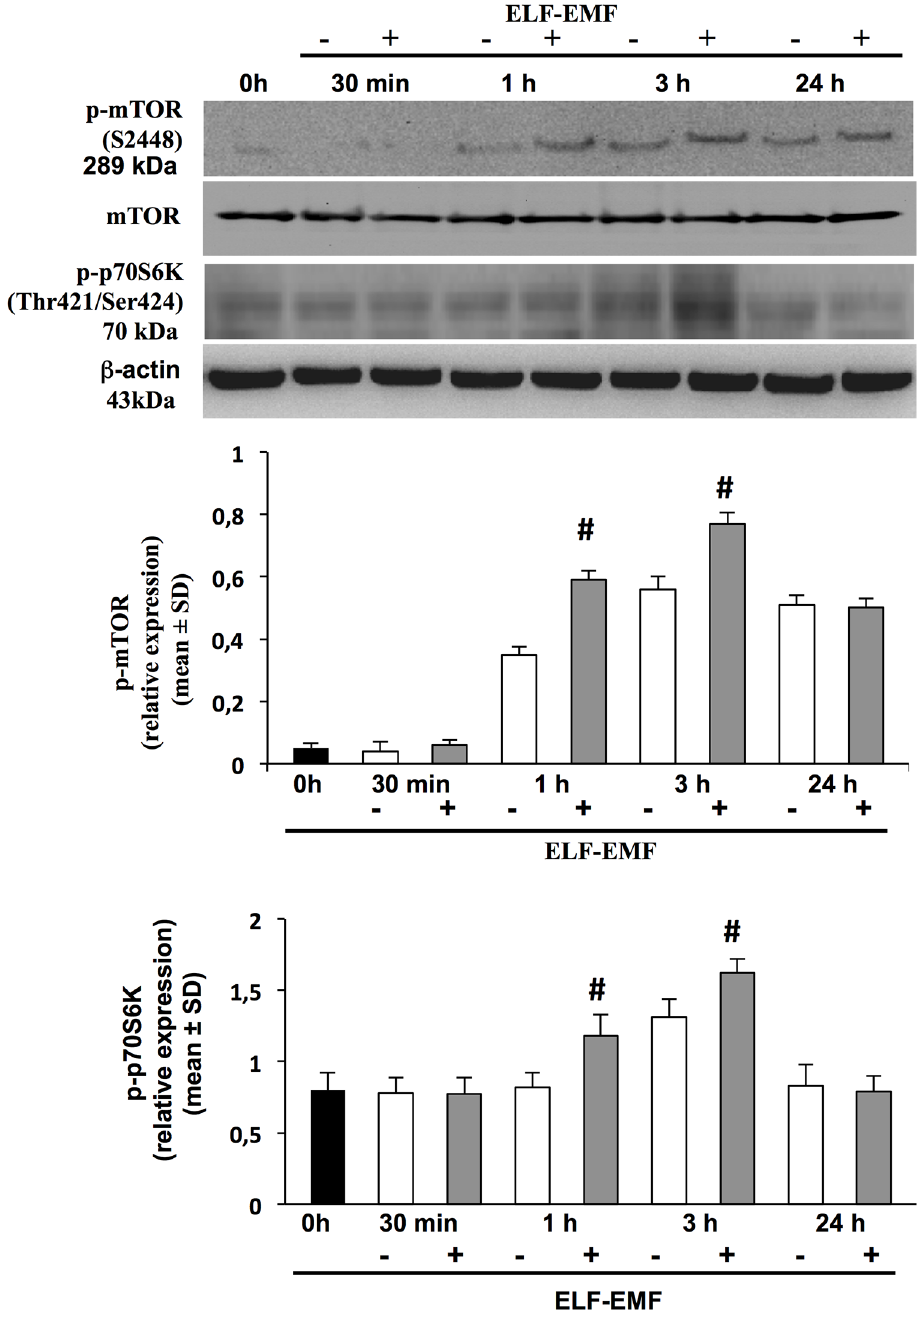
Fig 5. ELF-EMF exposure regulates phosphorilation of mTOR, p70S6k. Expression levels of mTOR and phosphorilated forms for mTOR (p-mTOR) and p70S6k (p-p70S6k) or ß-actin were analyzed by Western blotting, in total lysates derived from HaCaT cells exposed or not to ELF-EMF at 30 min, 1, 3 and 24 h, using specific antibodies. Immunoreactive band were analyzed by densitometry and the relative expressions of p- mTOR to the un-phosphorilated protein, of p-p70S6k to the b-actin are calculated. Each value represents the mean ± SD of three different experiments performed in duplicate ( # p < 0 . 05)